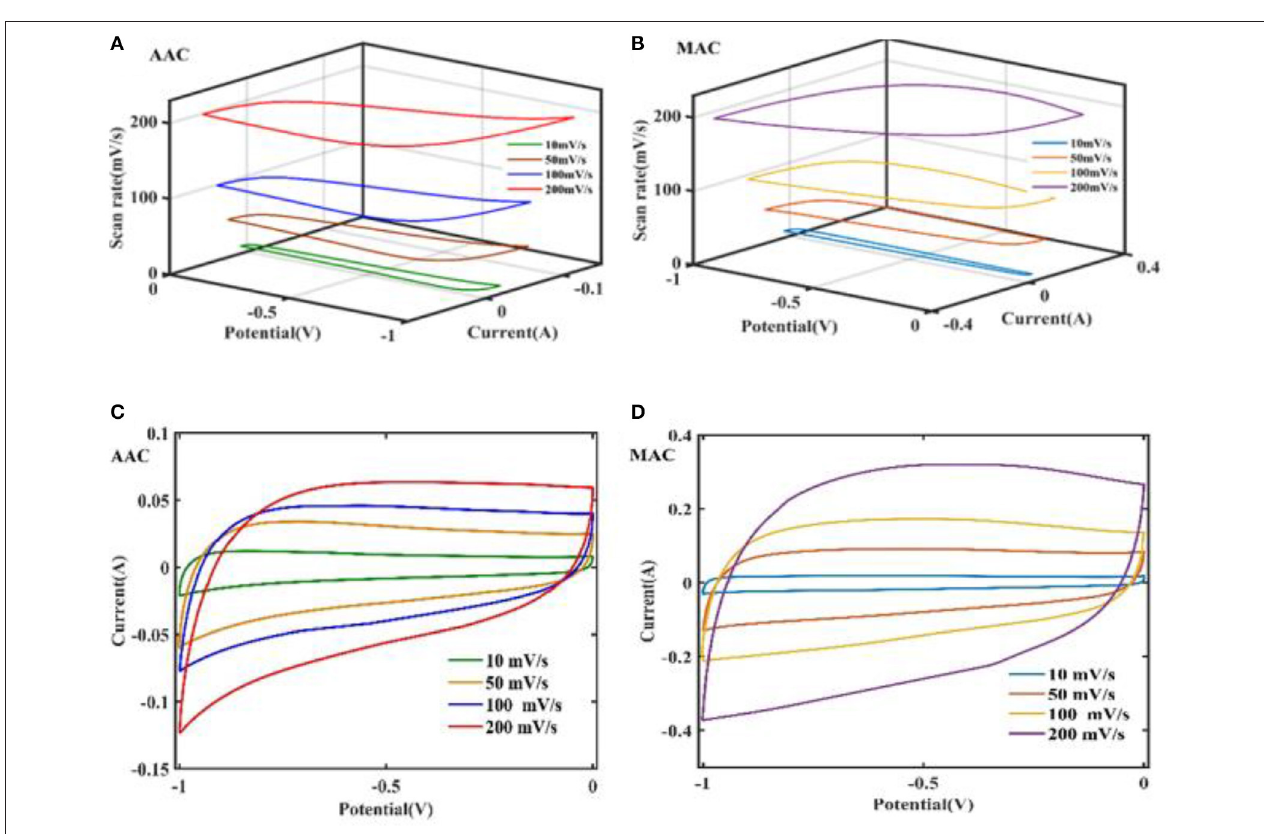
FIGURE 6 | 3D-CVcurves of (A) AAC and (B) MAC at different scan rates; CV curves of (C) AAC and (D) MAC in potential-current plane at different rates; CV curves of AAC.